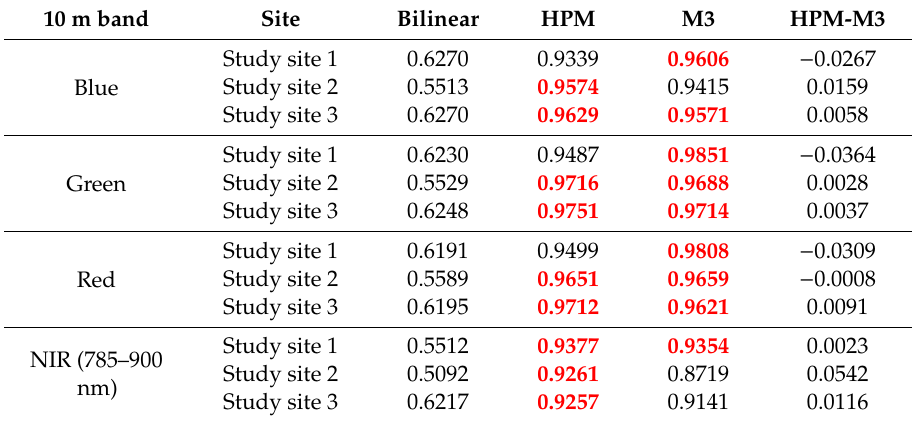
Table 8. Spatial subset Q 2 n values derived considering the four Sentinel-2 10 m sharpened bands independently ( n = 1). The highest Q 2 n value (least distortion) for each study site is shown in red bold font, and if values are within two decimal places (i.e., | HPM-M3 | < 0.01), then both are shown in red bold.